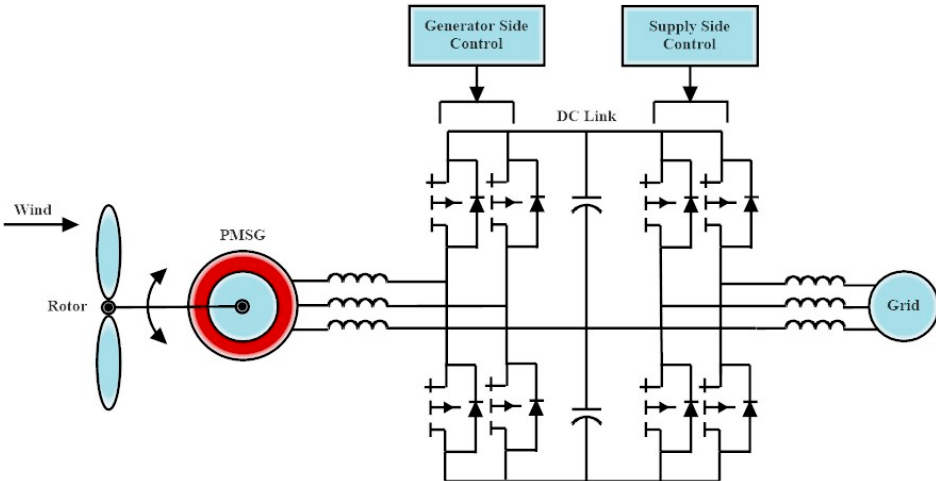
Figure 16. Back-to-back PWM VSI converter.